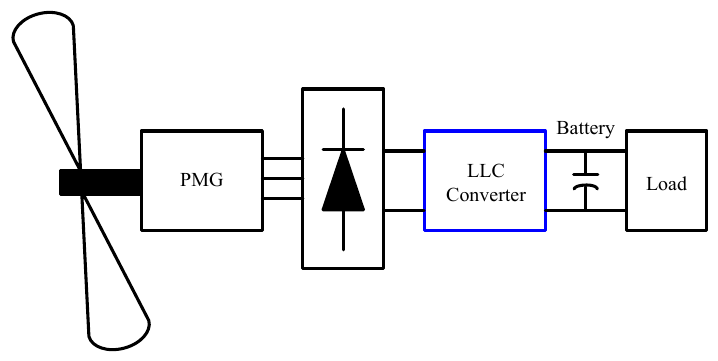
Figure 2. Stand-alone distributed wind power generation system. PMG: permanent magnet generator; and LLC: line level